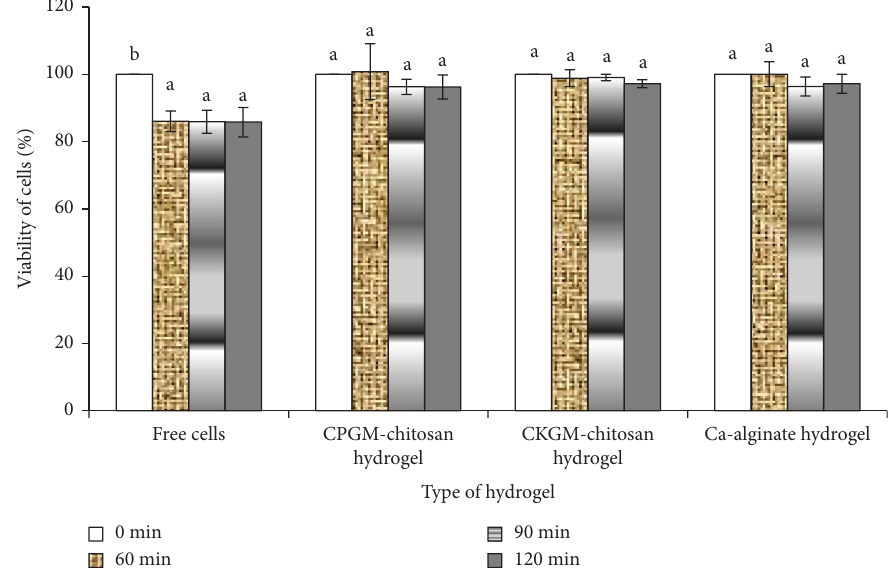
Figure 6: L. acidophilus FNCC 0051 cell viability during exposure to intestinal juice for 120min. Key: a or b, p < 0 . 05, CPGM: car- boxymethyl porang glucomannan, and CKGM: carboxymethyl konjac